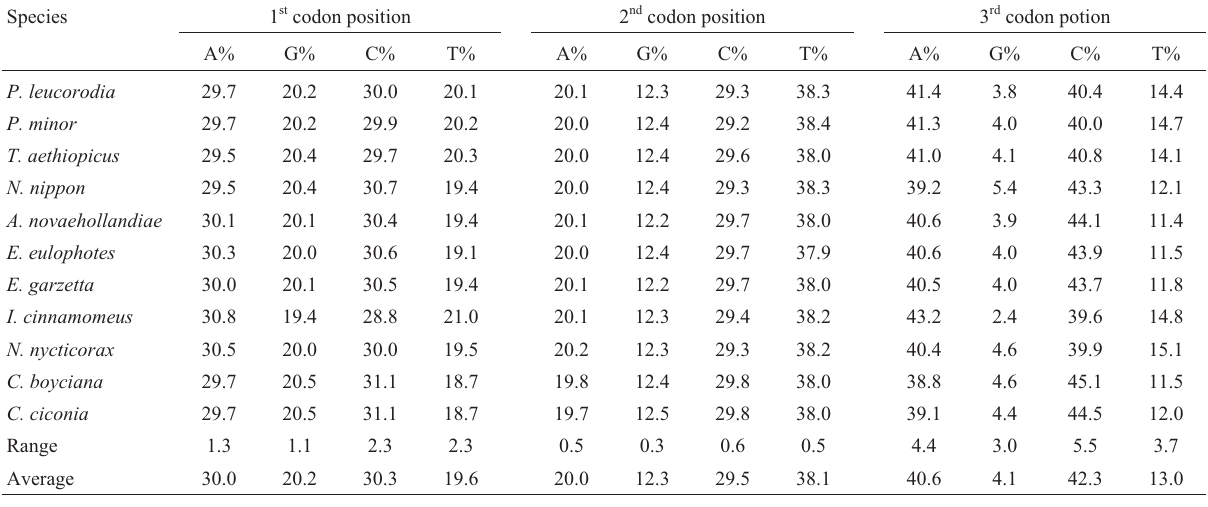
Table 4 - Nucleotide compositon of the 13 protein-coding genes.